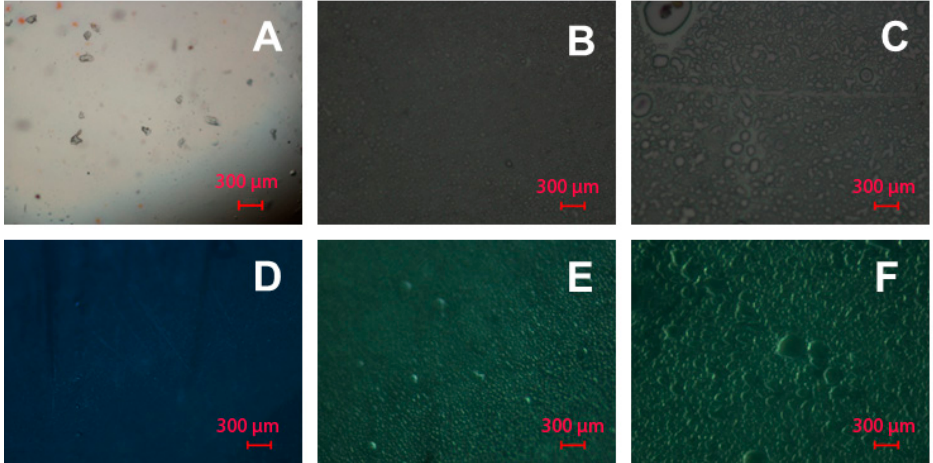
Figure 7. The images of the dried initial and modified PLA surfaces obtained by optical microscopy: ( A – C ) PLA, PLA-PAAm, and PLA-Alg in transmitted light, respectively; ( D – F ) PLA, PLA-PAAm, and PLA-Alg in reflected light, respectively.